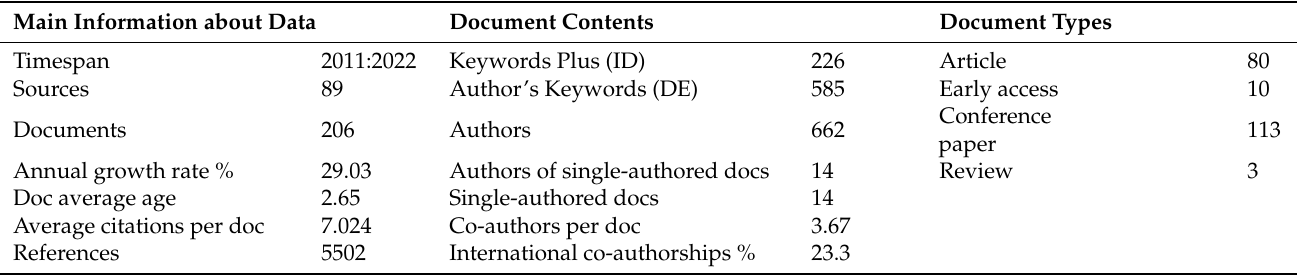
Table 3. Main information of Web of Science’s